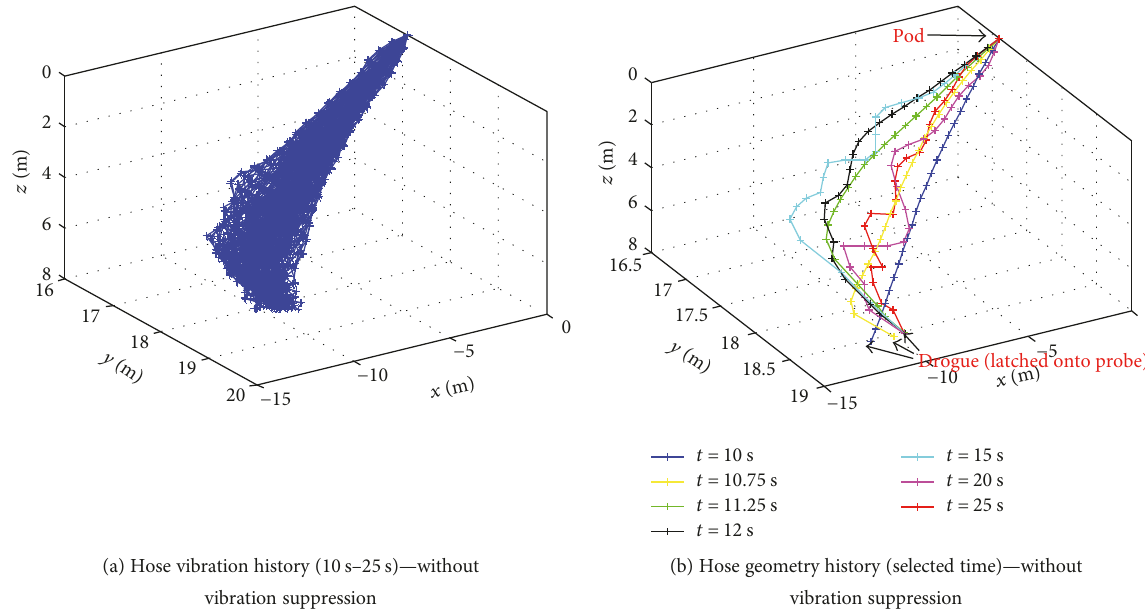
Figure 6: Flexible aerial refueling hose vibration during coupling without control